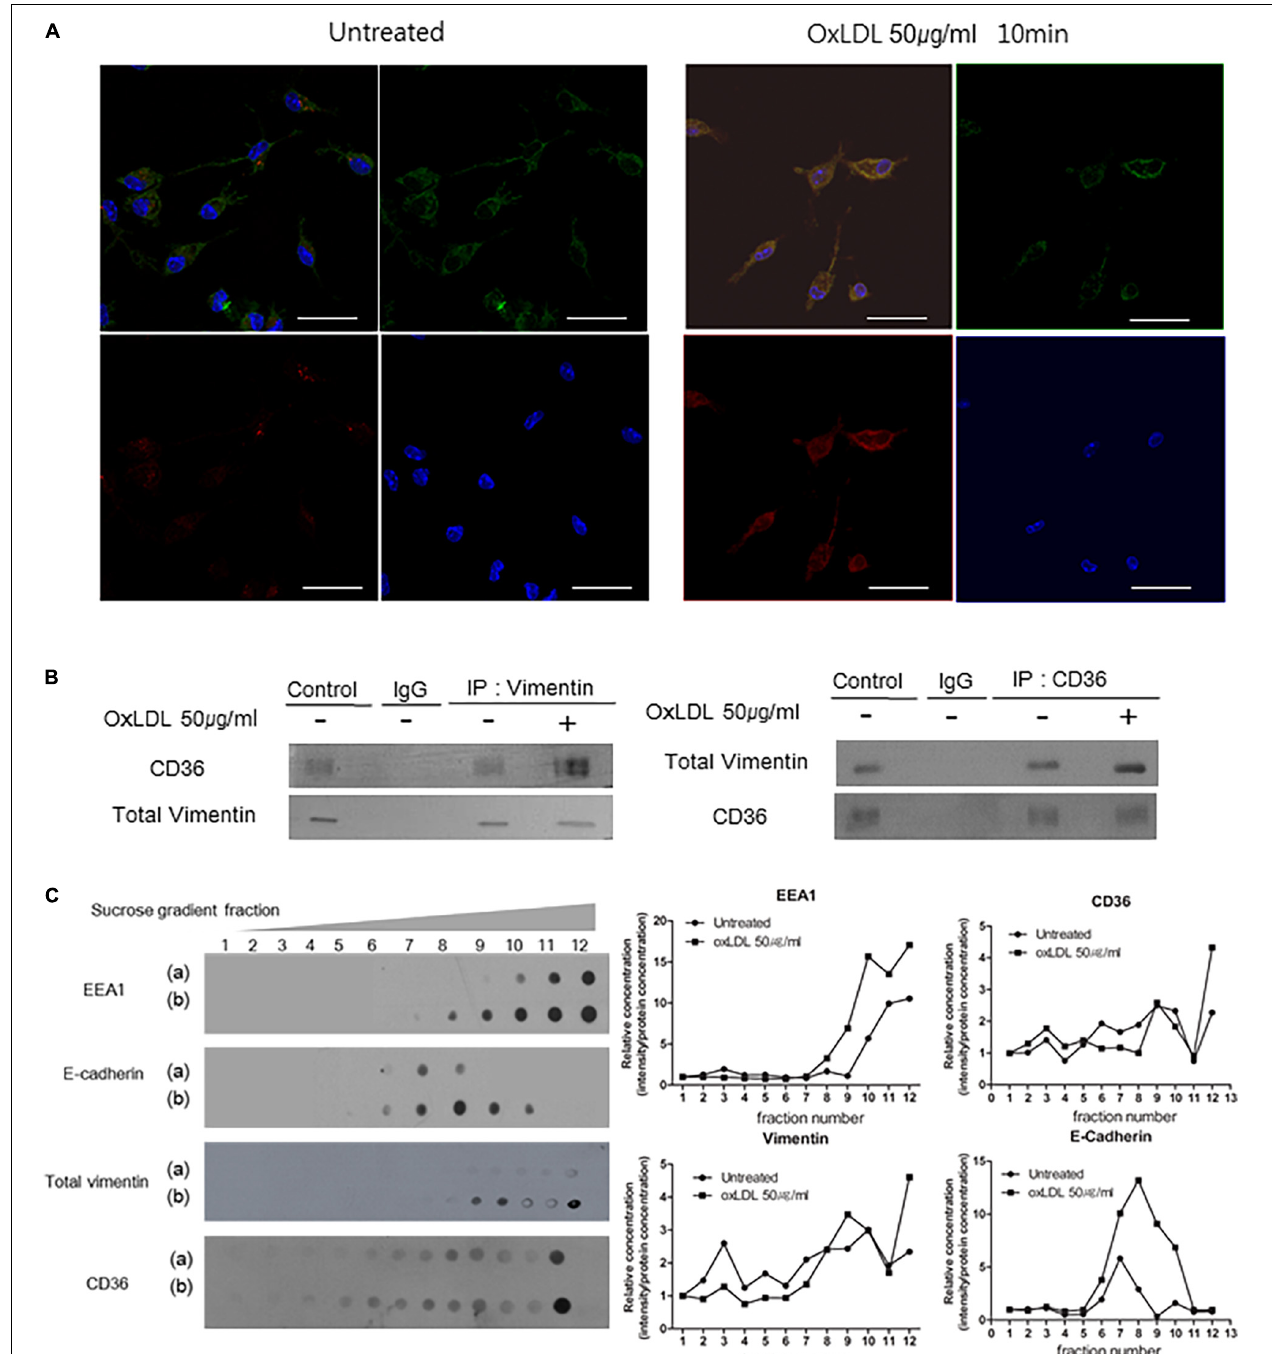
FIGURE 3 | OxLDL induces CD36-Vimentin colocalization in early endosome. (A) Representative immunocytochemistry images of wild type macrophages incubated with or without oxLDL (50 µ g/ml) for 10 min. Cells were stained with a rabbit polyclonal antibody to CD36 (Dylight 594; Red) and a mouse monoclonal antibody to vimentin (Alexa 488; Green). Scale Bars represent 20 µ m. (B) Vim + / + mouse peritoneal macrophages were treated with or without oxLDL (50 µ g/ml) for 10 min and immunoprecipitated with indicated antibodies. The precipitants were analyzed by western blot with antibodies against vimentin and CD36. (C) Sucrose gradient early endosome fraction test. Wild type macrophages were incubated with or without oxLDL (50 µ g/ml) for 10 min and homogenized. The lysates were added to 15 ∼ 40% sucrose gradient column and centrifuged. (a) oxLDL-untreated and (b) oxLDL-treated macrophage lysates. Immunoblot analyses for indicated proteins.